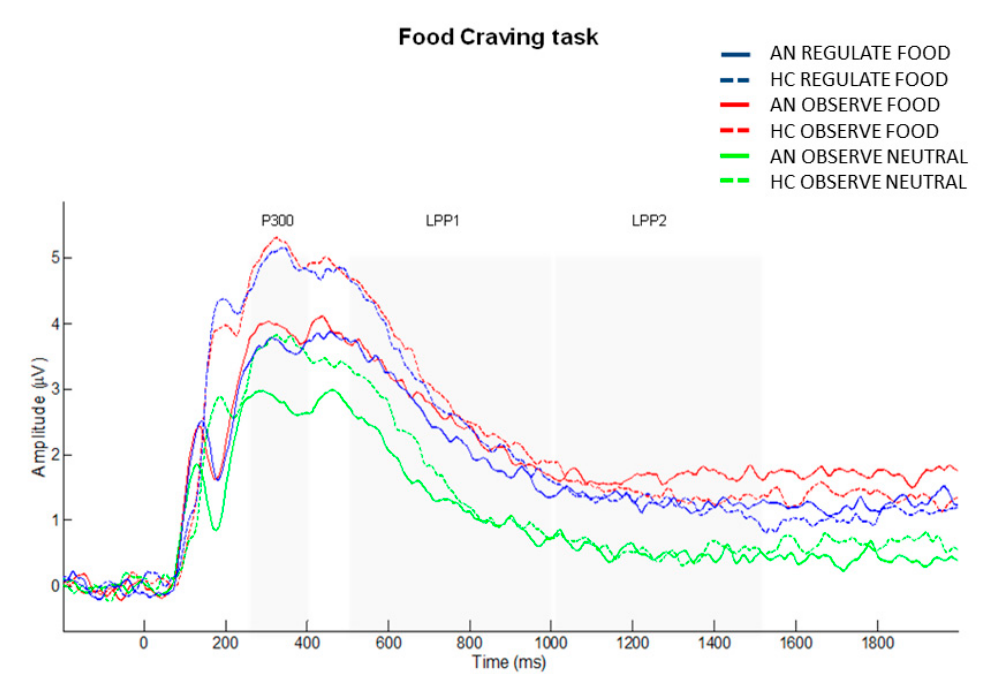
Figure 2. Grand average waveforms of the FRC task, for each experimental condition (Regulate Food, Observe Food, Observe Neutral) and group (HC, AN), in the centro-parietal cluster of electrodes.